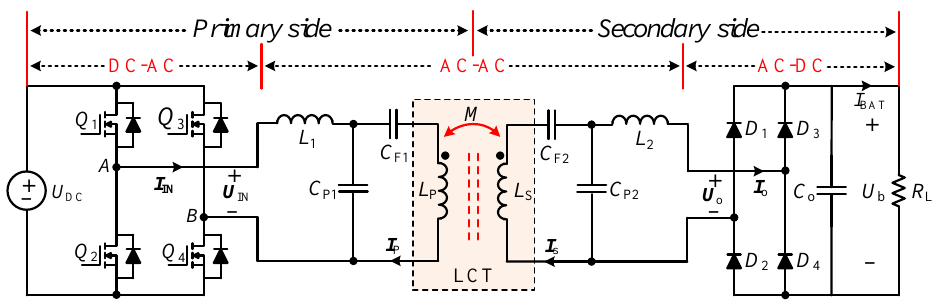
Figure 2. DS-LCC compensated WPT charging systems. On the primary side, the DC source U DC was converted to a square wave voltage U IN through the full bridge inverter (FBI) and then flowed into the DS-LCC resonance compensation topology. L 1 , C P1 , and C F 1 represent the primary side compensated inductor and capacitors. L 2 , C P2 , and C F 2 are the secondary side compensation components. C F 1 and C F 2 are the DC blocking capacitors used to eliminate the DC current component. M is the mutual inductance between the two sides. Q 1 – Q 4 represent SiC metal–oxide semiconductor field-effect transistors (MOSFETs) of the FBI, while D 1 – D 4 represent diodes of the rectifier. U O and I O represent the output voltage and current of the DS-LCC topology, respectively.